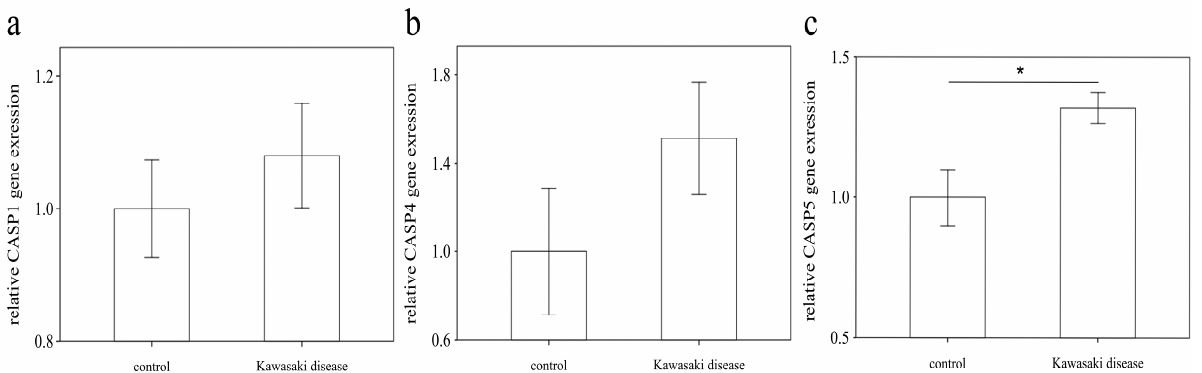
Figure 5. Analyses of CASP1 ( a ), CASP4 ( b ), and CASP5 ( c ) mRNA levels in human monocyte cell (U937) experiments after treatment of 10% of pooled KD patients’ plasma and pooled healthy control from 10 individuals for 72 h in vitro, using a real-time quantitative polymerase chain reaction. Data are expressed as mean ± standard error. Data analyzed by Student’s t -test and reported as the p -values of the comparisons of interest. * indicates significance ( p < 0.05) between the groups. KD: Kawasaki